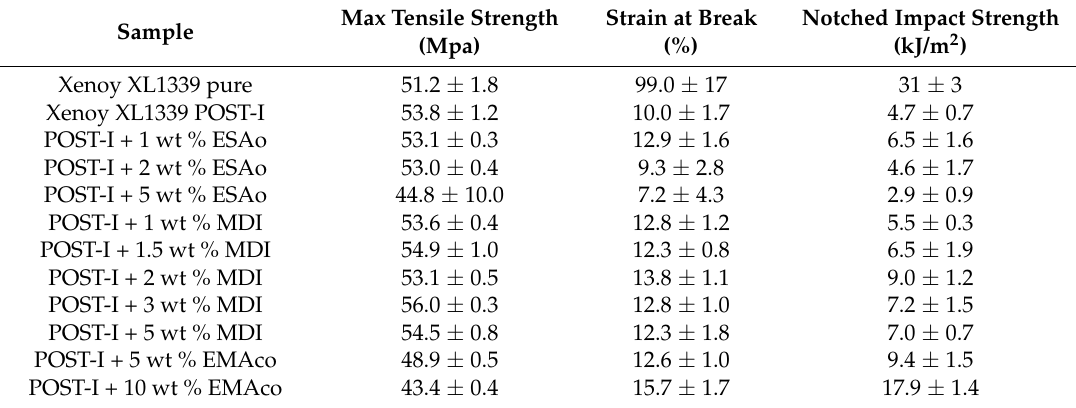
Table 4. Mechanical properties of POST-I blend with different amounts of the compatibilizers that were